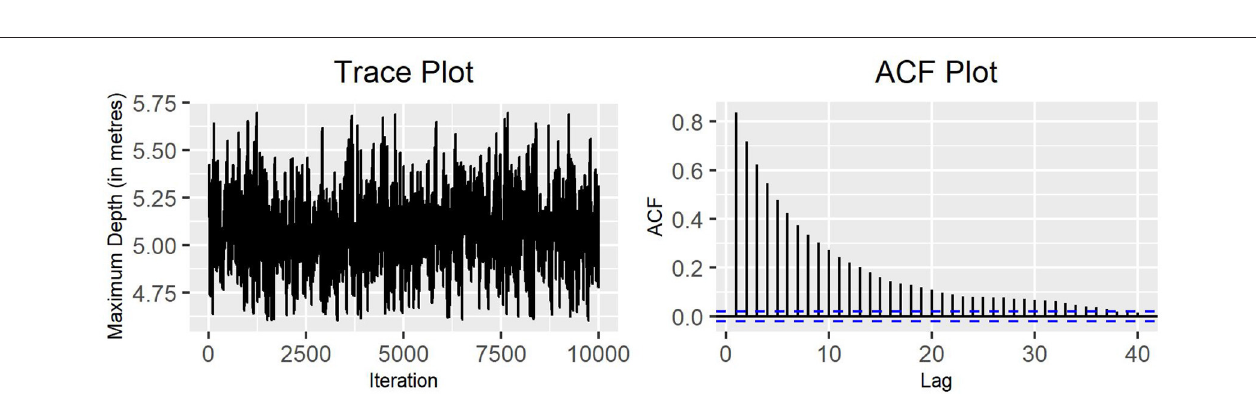
FIGURE 6 | Trace plot and ACF plot of the standard deviation of the variable maximum depth for production state 2, obtained running four chains for parallel tempering on the MH algorithm (10,000 iterations).